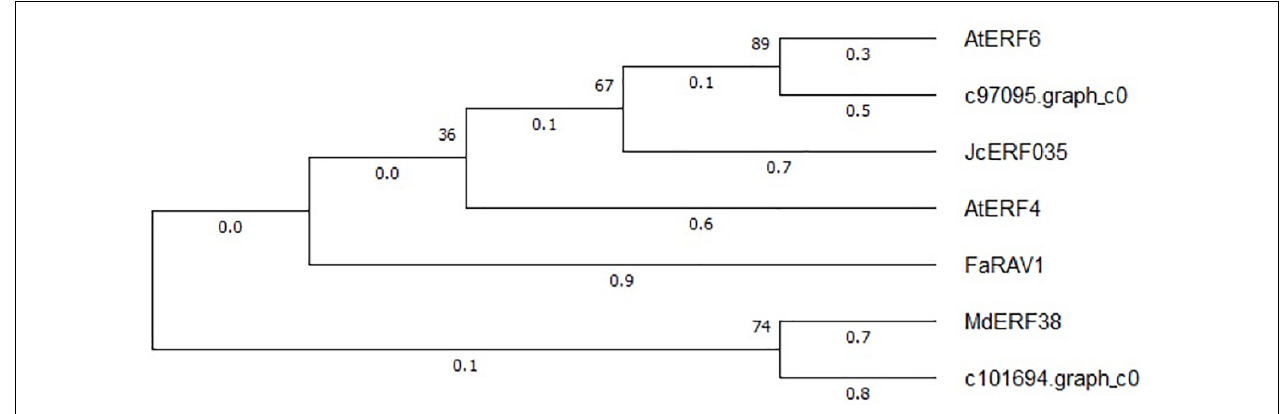
FIGURE 9 | Phylogenetic tree of two selected AP2 unigenes and AP2 TFs from other plant species. The sequences included Arabidopsis thaliana AtEFR6 (AB013301.1), Jatropha curcas JcERF035 (XM_012237693.3), Arabidopsis thaliana AtERF4 (NM_112384.2), Fragaria × ananassa FaRAV1 (XM_011466945.1), and Malus domestica MdEFR38 (MG099847.1).